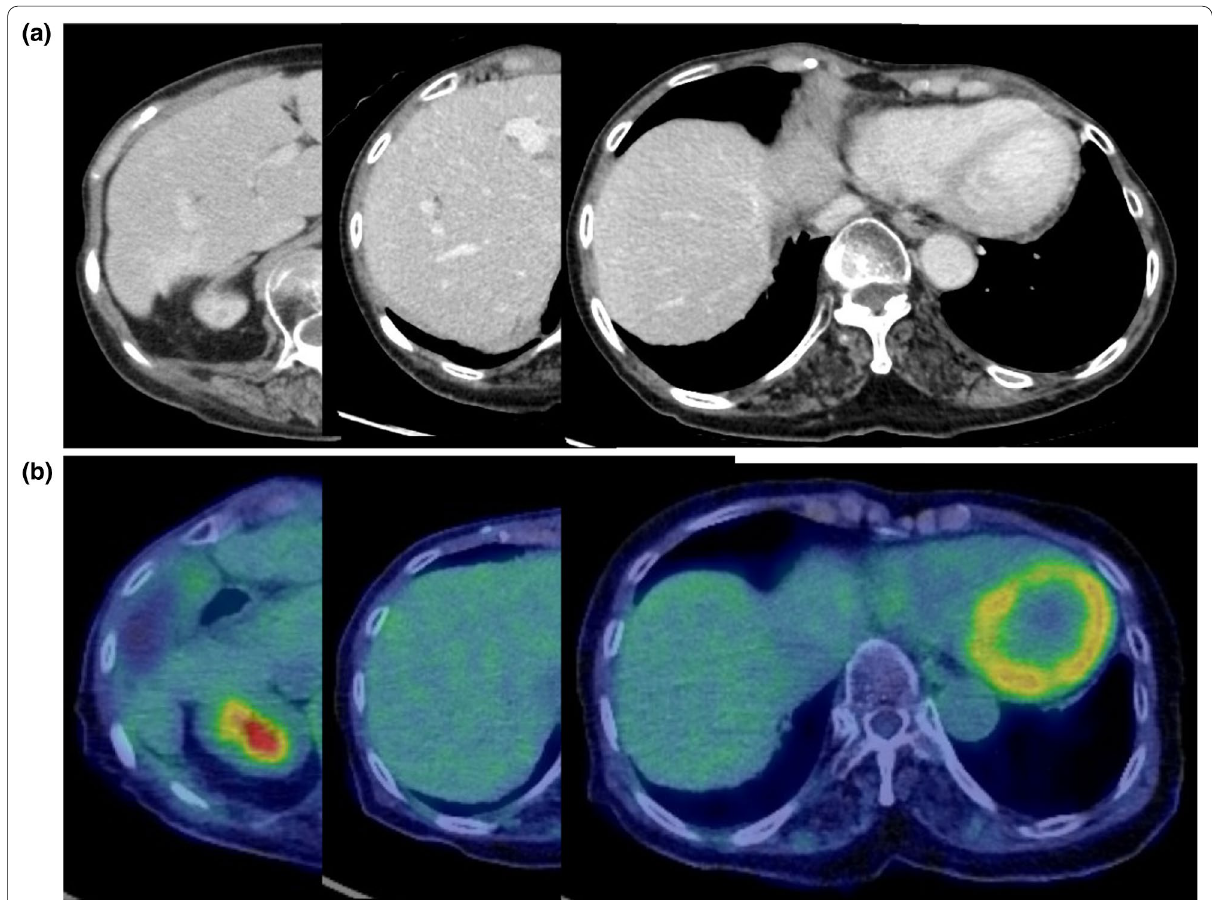
Fig. 7 a Abdominal CT showing complete remission of liver metastases. CT computed tomography. b PET–CT scan showing no sign of recurrence. PET–CT positron emission tomography–computed